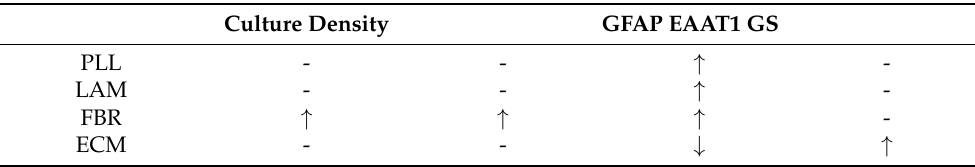
Table 1. Effects of different biomaterials on rat neonatal astrocytes in serum-free medium in physiologically normoxic conditions.